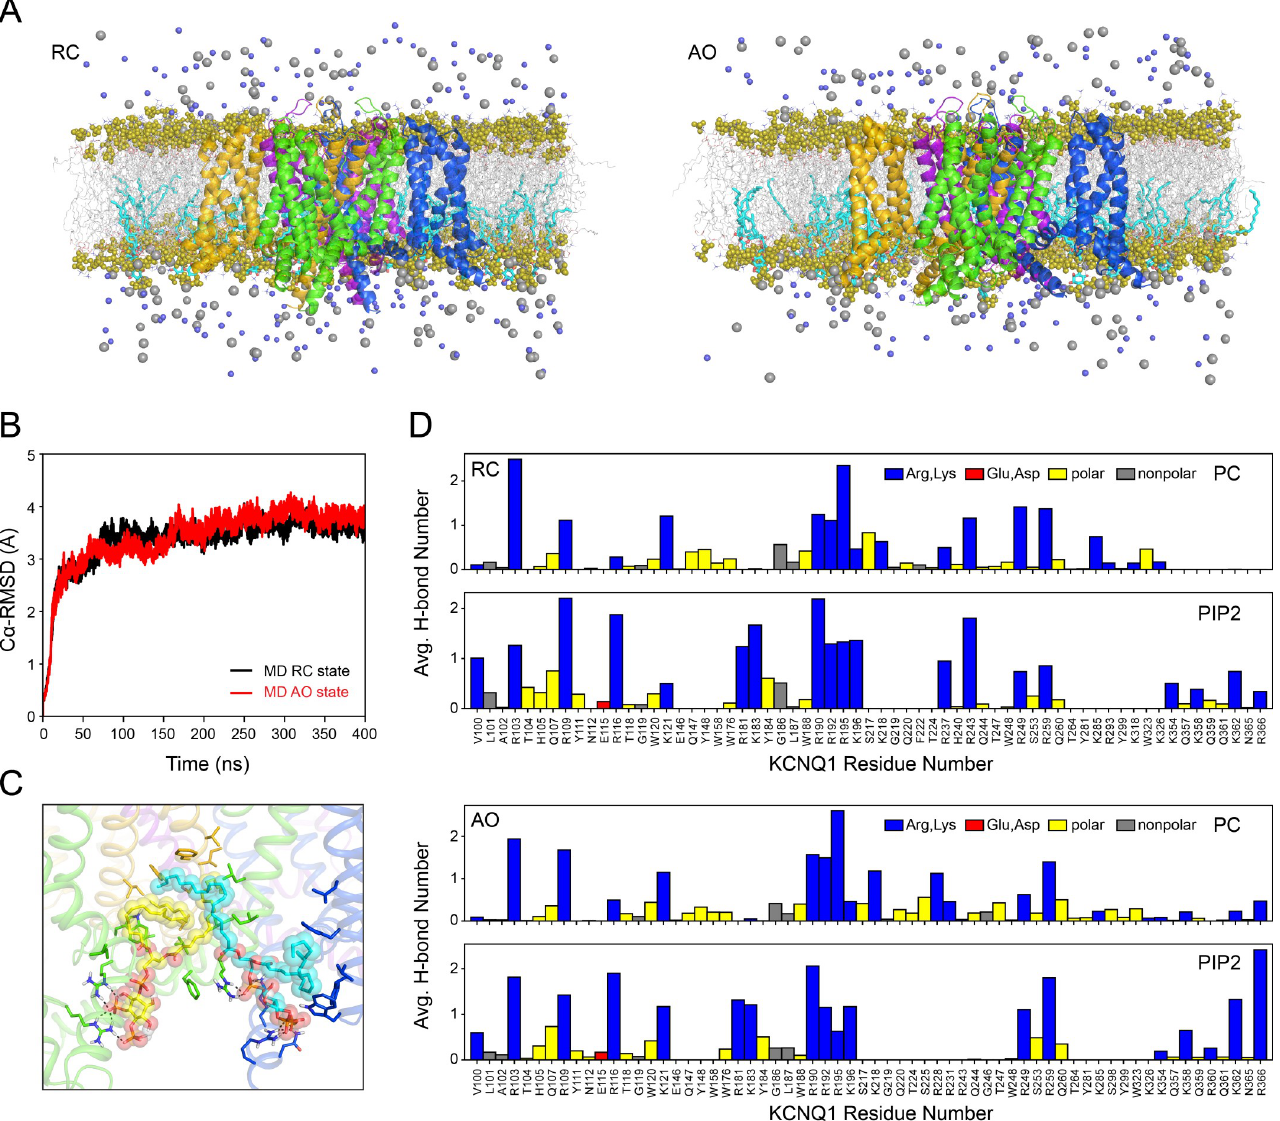
Fig 4. MD simulation of KCNQ1 homology models. ( A ) RC and AO models embedded in a POPC bilayer that contained 10 mol% PIP2 in the inner leaflet. The fatty acid chains of POPC and PIP2 molecules are depicted by gray and cyan sticks, respectively, and the head group phosphates are represented as olive spheres. Potassium and chloride ions are displayed as gray and light blue spheres and water molecules are excluded for clarity. ( B ) C α -atom RMSD relative to the starting structure over the course of an MD trajectory for the RC and AO model. RMSD plots for all four RC and AO state MD simulations, respectively, are shown in S4 Fig . ( C ) Snapshot of the interaction of two PIP2 molecules with KCNQ1 as observed in MD. PIP2 molecules are drawn as spheres with carbon atoms colored yellow or cyan, respectively, and oxygen and phosphorous atoms colored red and orange, respectively. Different KCNQ1 subunits are colored green, blue, purple and orange. Side-chains of nearby KCNQ1 residues are depicted as sticks with heteroatoms and polar hydrogen atoms colored by their chemical identity (hydrogen: white, oxygen: red, nitrogen: blue). Potential hydrogen bond contacts are indicated by dashed lines. ( D ) Average number of hydrogen bonds per MD frame between KCNQ1 residues and phosphate groups in PC and PIP2 head groups calculated over the course of all RC and AO state MD